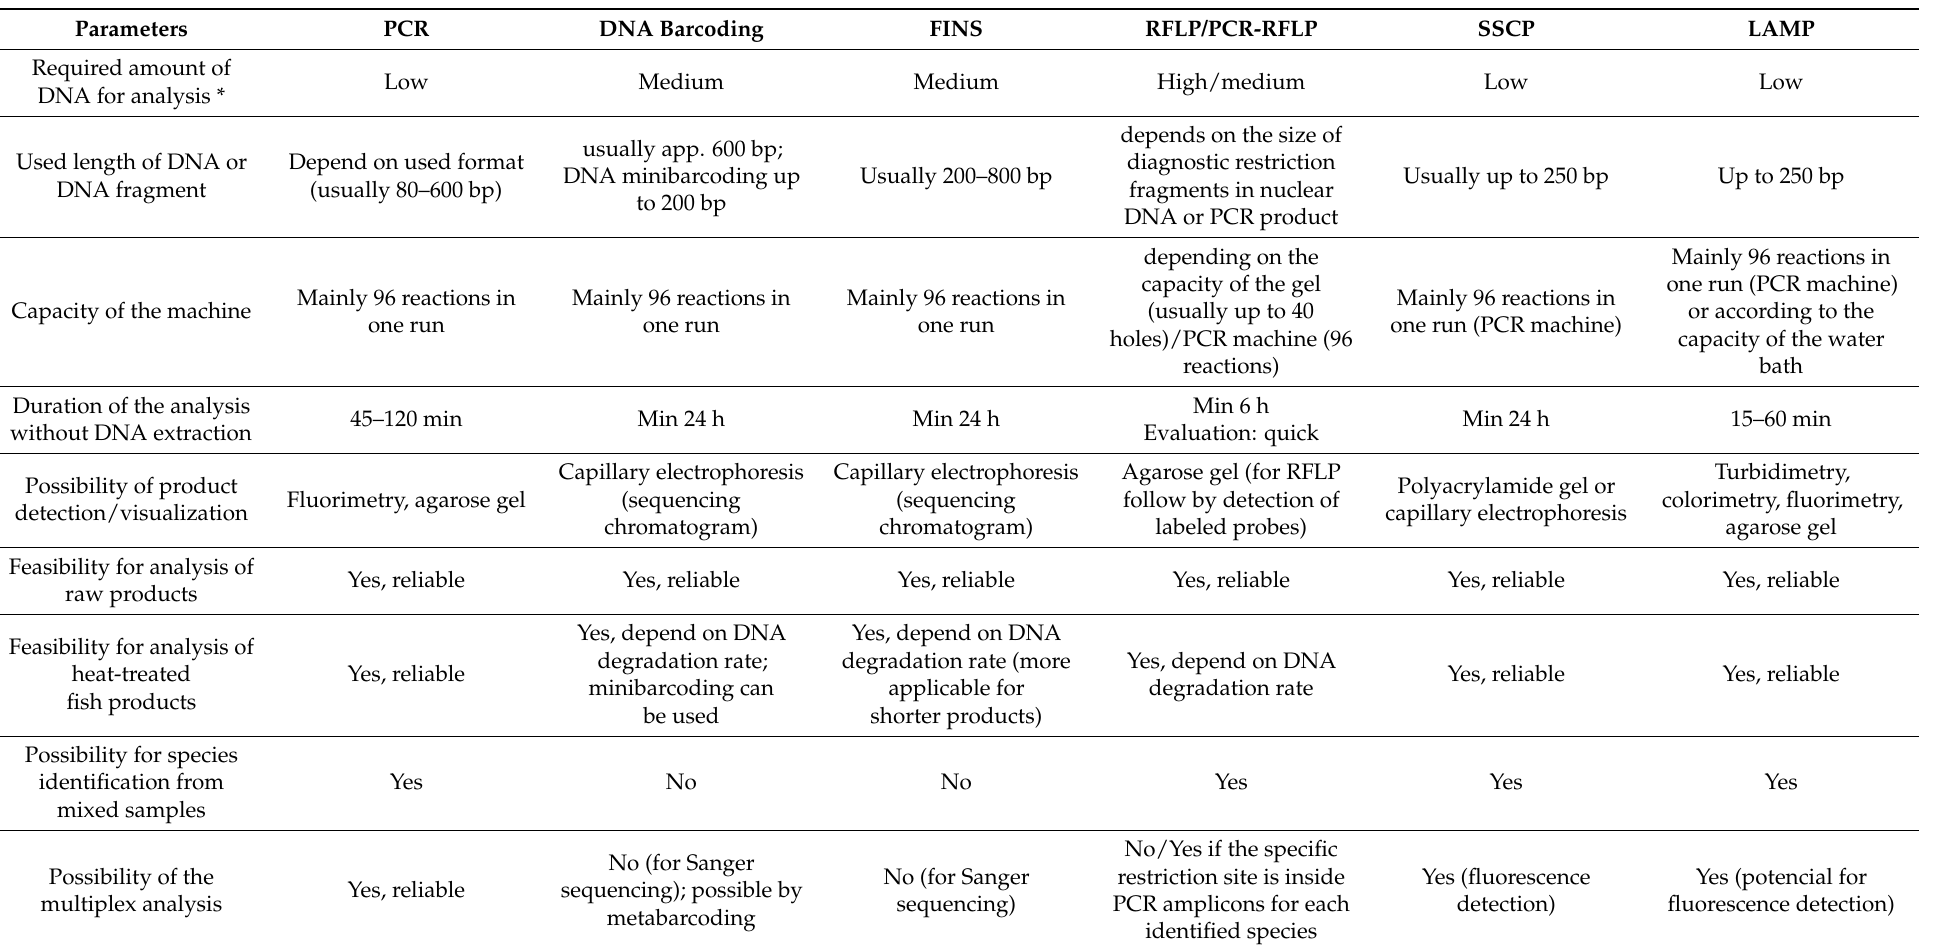
Table 2. Comparison of parameters for selected